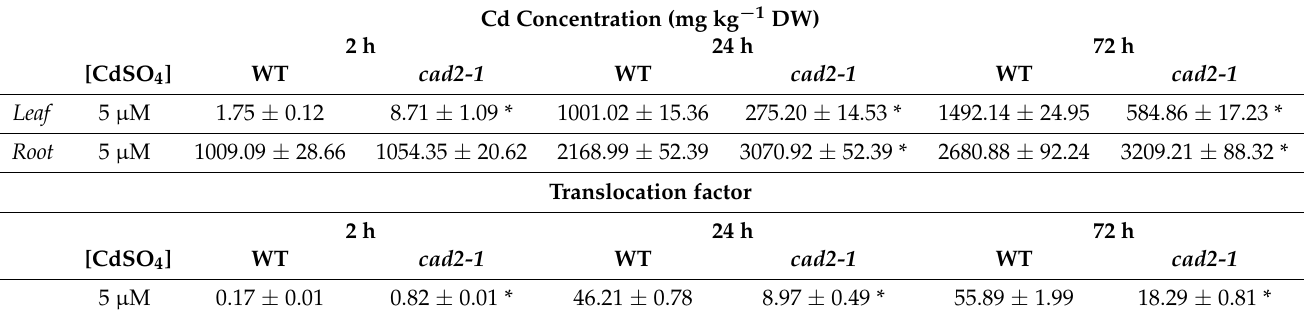
Table 1. Root and leaf cadmium concentrations (mg kg − 1 dry weight) and the corresponding Cd translocation factors (%) of 3-week-old wild-type (WT) and cad2-1 mutant Arabidopsis thaliana plants grown under control conditions (0 µ M CdSO 4 ) or exposed to 5 µ M CdSO 4 during 2 h, 24 h, and 72 h. Data are presented as the mean ± S.E. of at least four biological independent replicates. Significant differences ( t -test: p < 0.05) between both genotypes and within each time point are indicated with an asterisk (*). Data obtained from non-exposed (0 µ M CdSO 4 ) plants are not shown, as Cd concentrations were below the limit of detection.